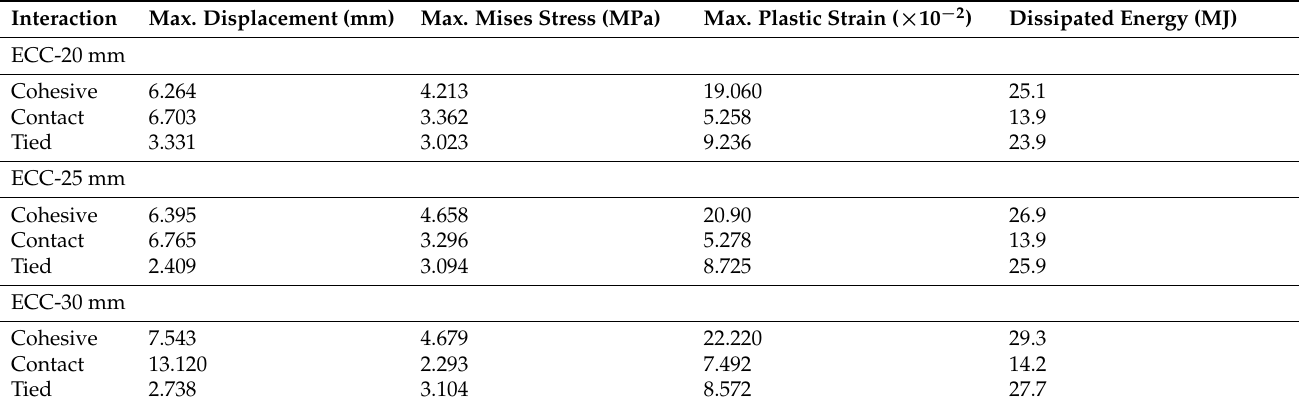
Table 8. Comparison between the mechanical parameters of the walls reinforced with different ECC thicknesses and